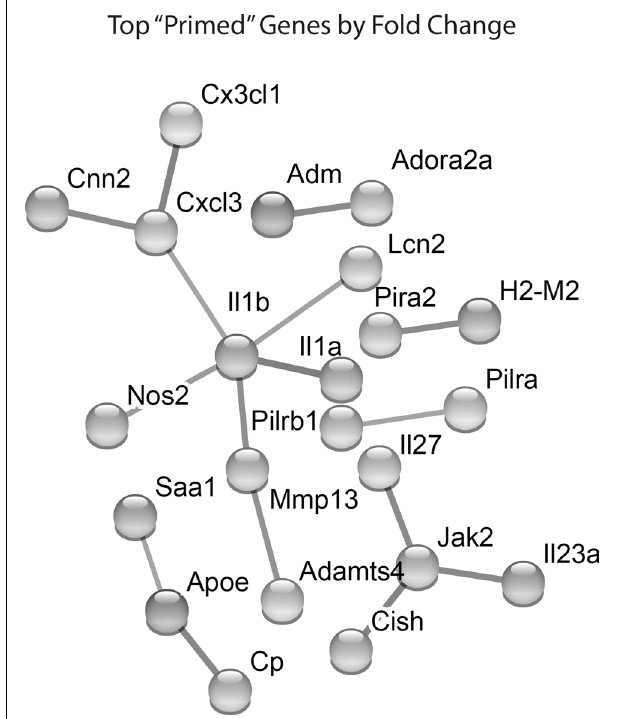
FIGURE 4 | STRING network analyses reveal primed genes are immune-related. Analyses were performed on the top 100 primed genes with the largest fold changes. Gene expression results are derived from n = 3 biological